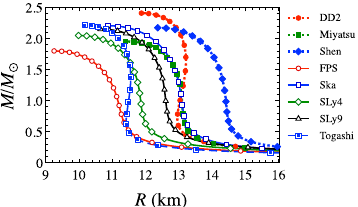
Fig. 3. But, for the case of the p 1 -mode we can not